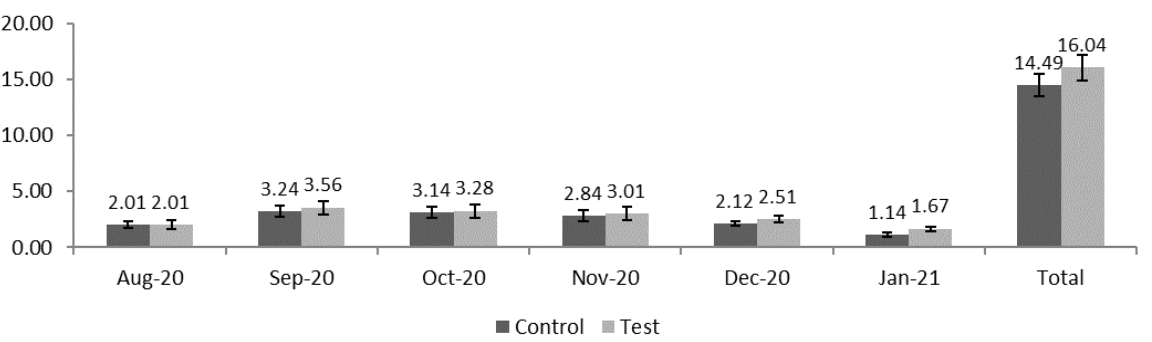
Figure 4. Marketable yield (kg/m 2 ) per experimental piece per month.